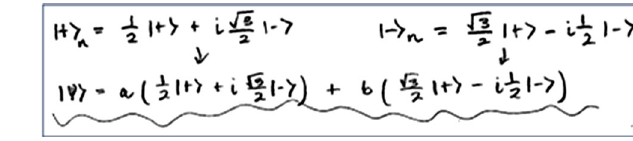
FIG. 7. The start of a student ’ s solution to a change-of-basis question. This student employs the substitution method, where they insert the basis conversions into the generic basis repre- sentation. The subsequent steps (not shown) involve rearranging terms, setting each coefficient equal to the coefficient of the given state, and solving a system of equations for a and b . Reproduced from Ref.